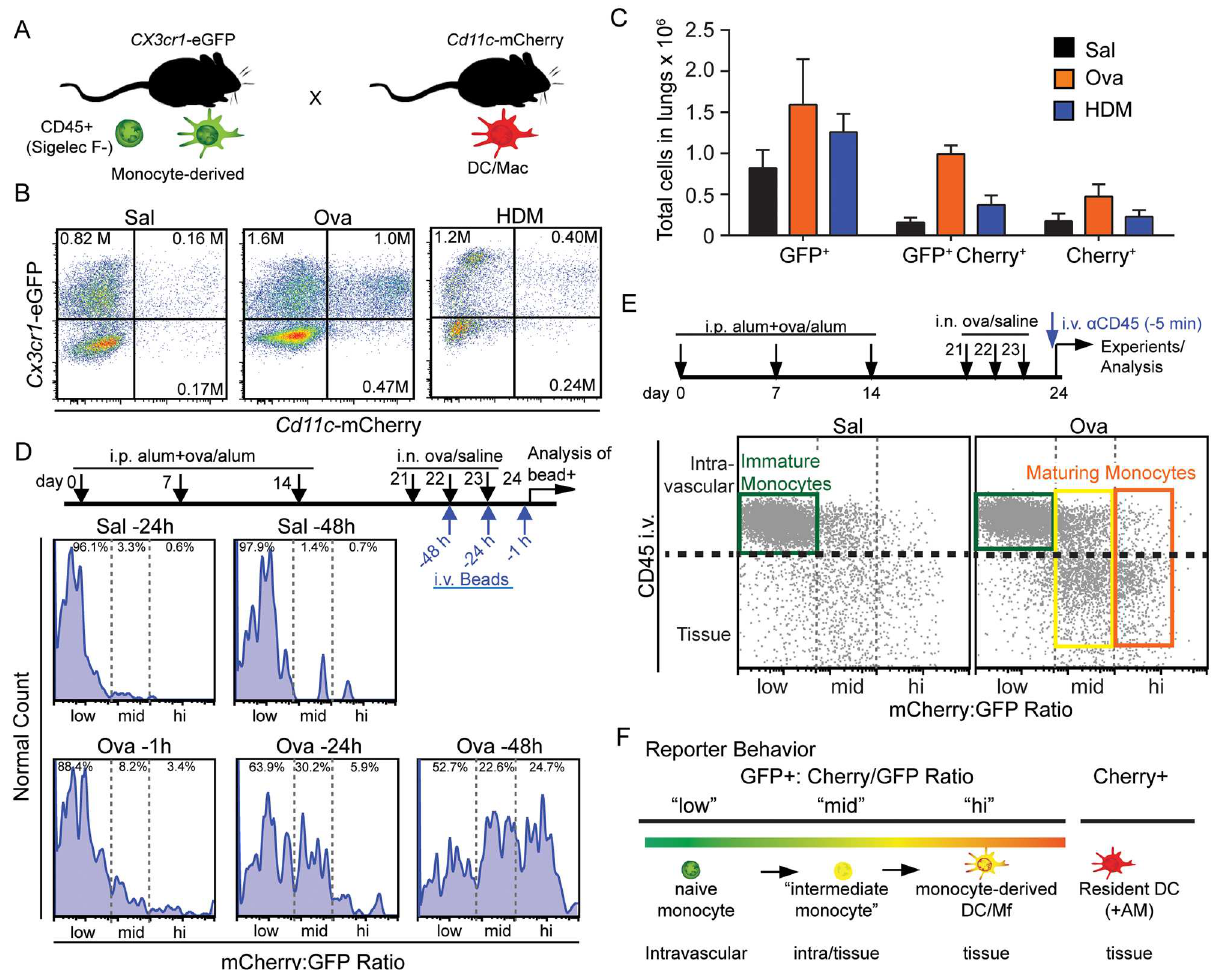
Fig 1. A dual reporter system reveals maturation of monocytes inside and outside of the lung vasculature. ( A ) Illustration of the Cx3cr1 -eGFP-Cd11c-mCherry transgenicmouse model used for lineagetracing of monocyte to DCs. ( B ) Flow cytometry with absolute numbers (insets) and ( C ) normalized total counts of GFP + and/or Cherry + cells in saline, Ova or HDM-treated lungs within a CD45 + CD11b + Siglec-F - Ly6G - gate. Data in C was normalized to input fluorescent polystyrene beads during lung digests. Data in B-C represent 3 independent experiments. ( D ) Experimental layout and results of intravenouslabelingof blood monocytes as a pulse with intravenousbeads (“pulse”), followedby tracking of bead+ lung-homing monocytes or monocyte-derivedcells over 48 hours during the “chase” period. Flow cytometry data is plotted as a ratio of the GFP and mCherry channel with gates for ‘low’ set based on Saline at -24 hours, ‘med’ based on OVA at -24 hours and ‘hi’ representing populationsthat appear predominantly after 48 hours. Data represent 3 independent experiments. ( E ) Experimental layout and resultant flow cytometric analysisof intravenous labelingof cells with high molecularweight anti-CD45 antibodies 5 minutes prior to euthanasia. CD45 + CD11b + Siglec-F - Ly6G - lung monocytic cells are plotted on the identicalCherry:GFP scale as (D), with the CD45 i.v. specifically labelingintravenousimmune populationsas delineated in S2B Fig. ( F ) Illustration of the extent of monocyte ! myeloid maturationand concomitttant tissue distribution that is differentiated by ratiometric